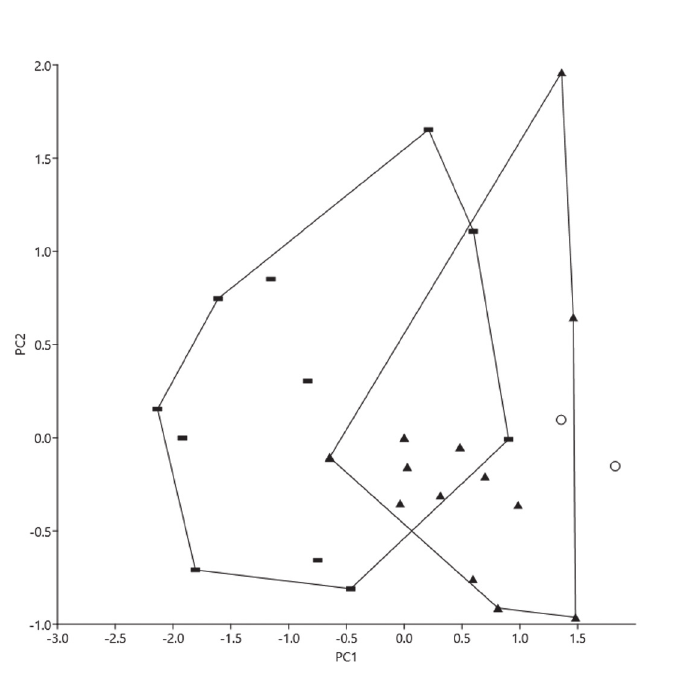
Fig. 9. Scatterplot of PC2 against PC1 for a PCA on 10 meristics (n = 36) of E. cf . atromaculatus (Nichols & Griscom, 1917): Epulu 2 ( ▲ ), and Ituri 8 ( ). Also shown are the type specimens of E. atromaculatus (Nichols & Griscom, 1917) ( ○